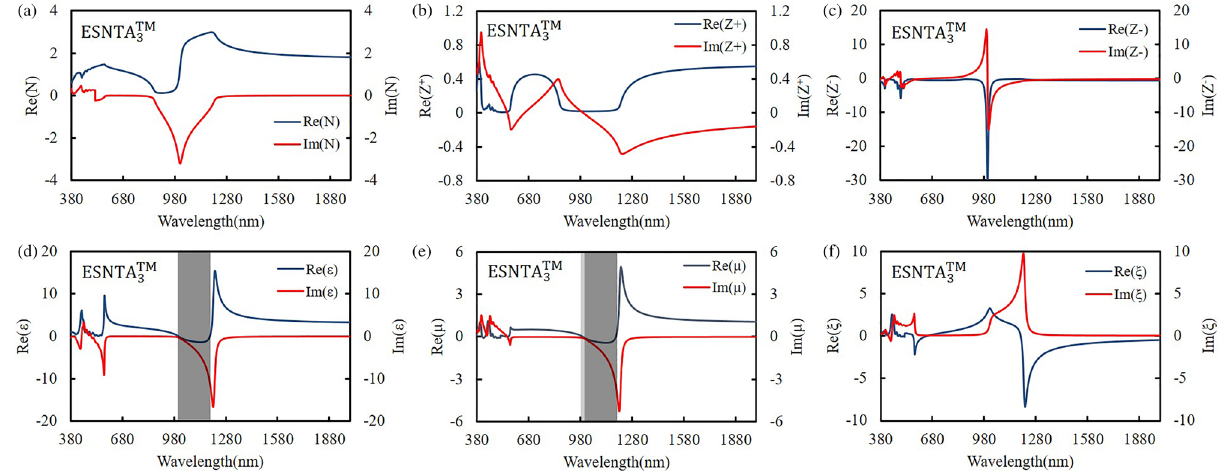
Figure 10. Retrieved ( a ) refractive index, ( b ) positive impedance, ( c ) negative impedance, ( d ) permittivity, ( e ) permeability, and ( f ) bianisotropy parameter for ESNTA 3TM .